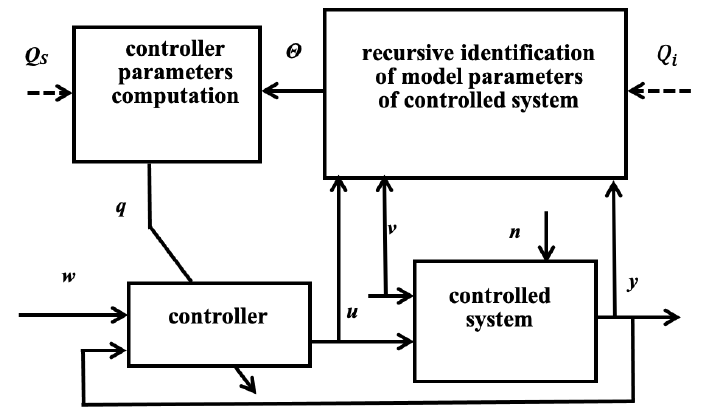
Figure 3. The general scheme of the self-tuning